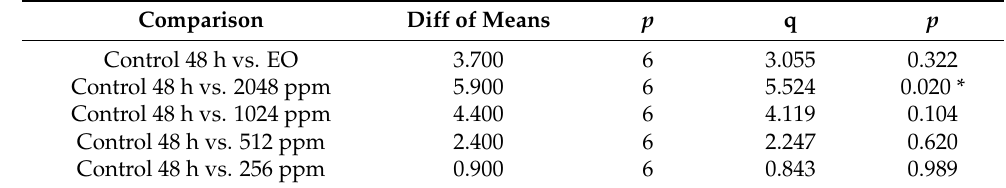
Table 4. One-way ANOVA between A. flavus colonies with or without the EO and the NE. Comparison Diff of Means